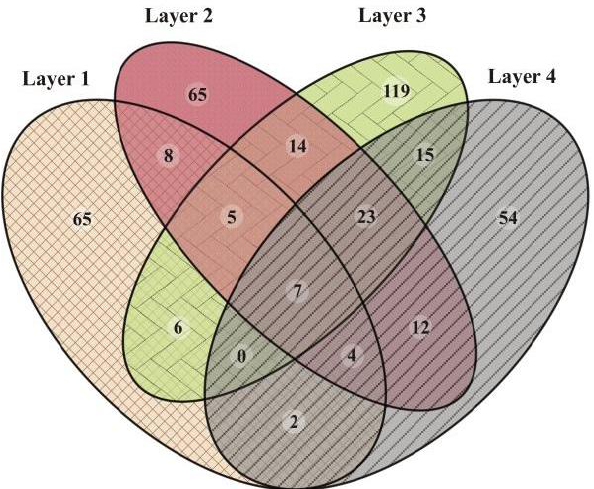
Figure 5. Venn diagram showing the number of unique or shared ASVs between the layers of the microbial mat.